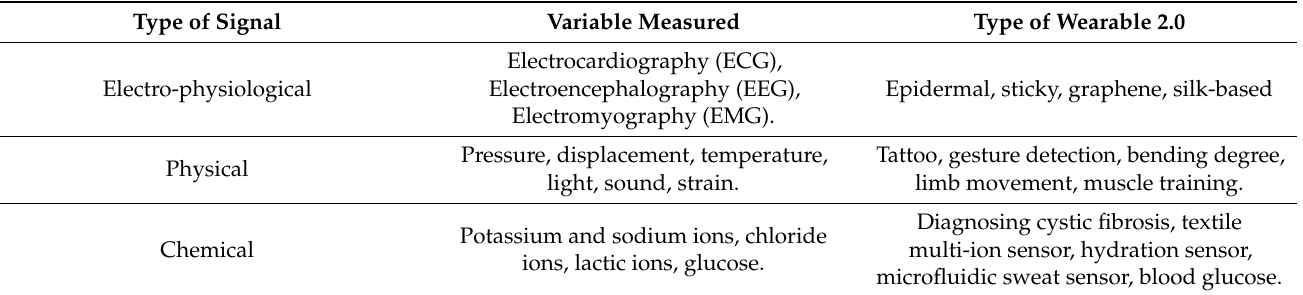
Table 1. Wearable